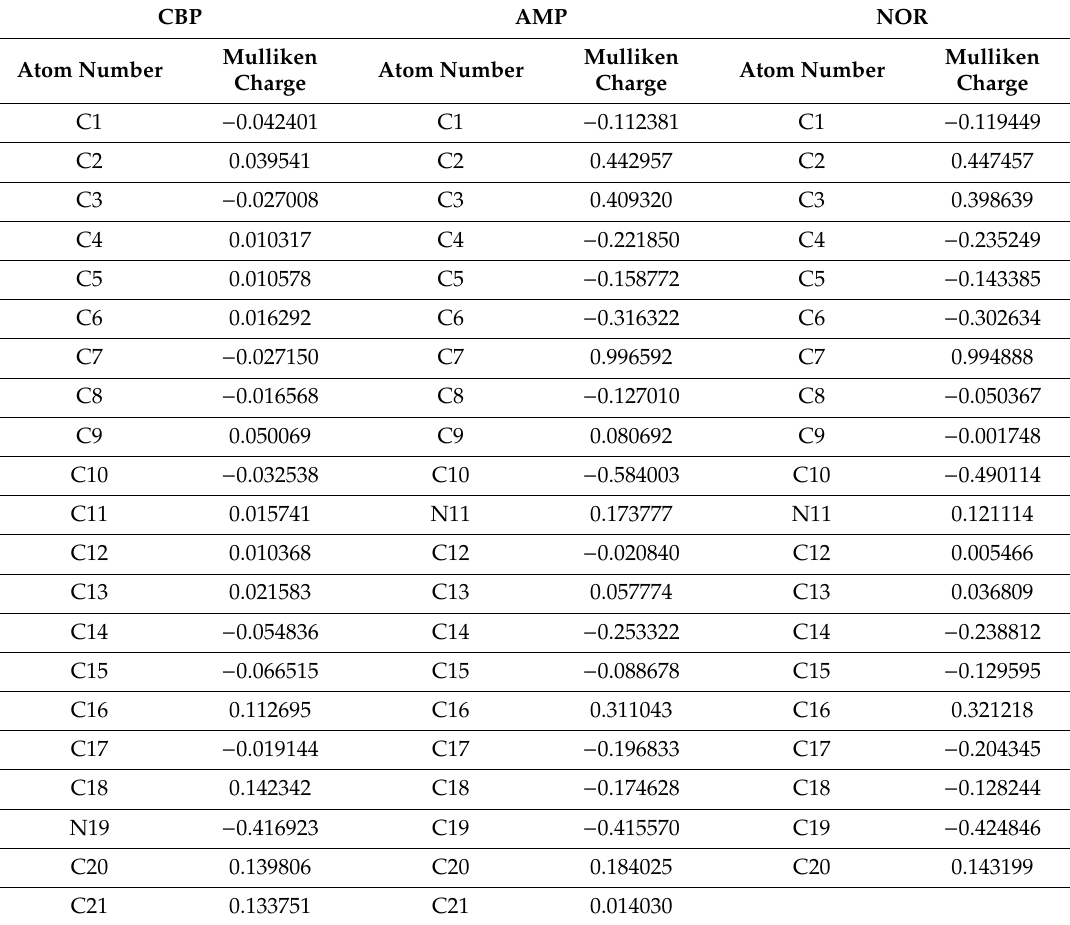
Table 1. Mulliken partial charges of CBP, AMP and NOR, represented in percentages of negative and positive charge of each individual atom with hydrogens